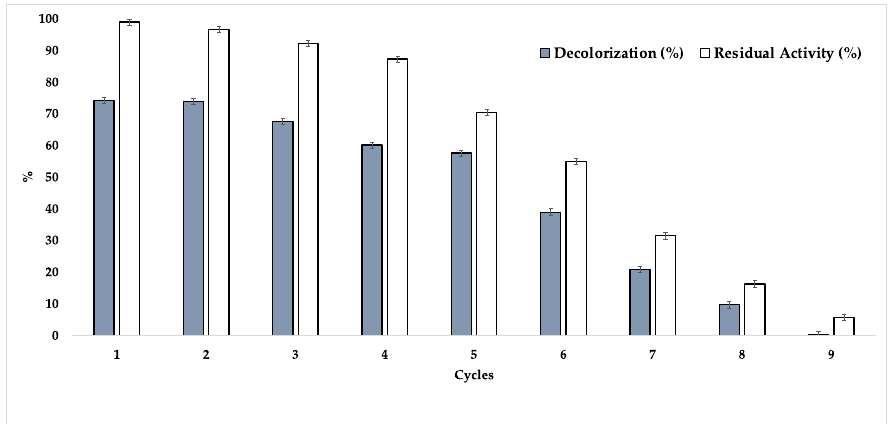
Figure 8. Recycling and determination of residual activity presented by immobilised L Asp in the decolorization of the RBBR dye.